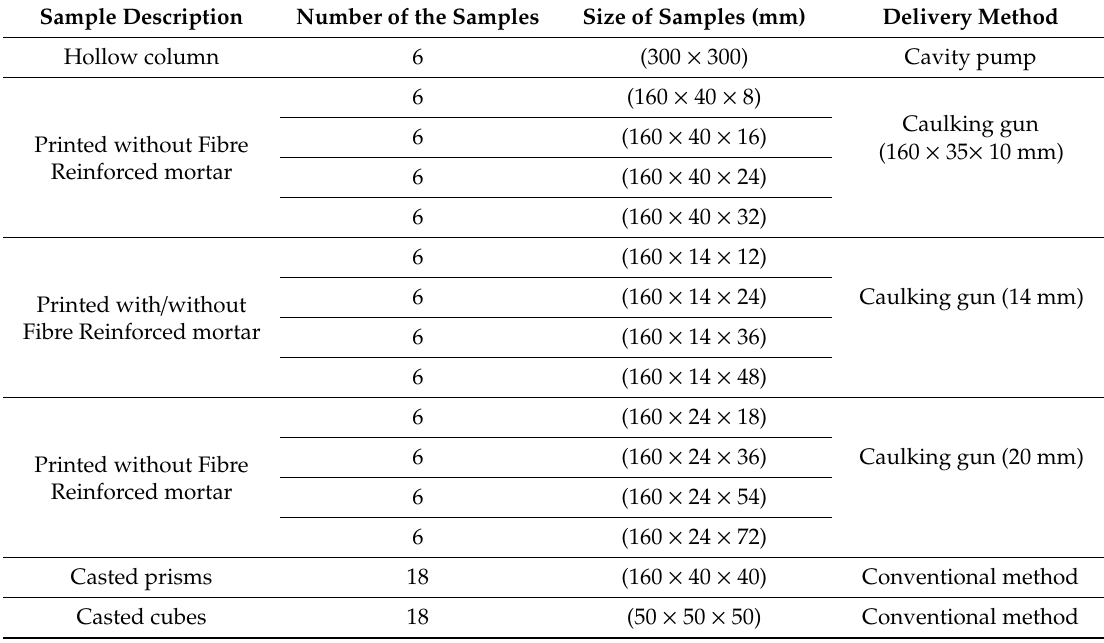
Table 3. Details of the prepared